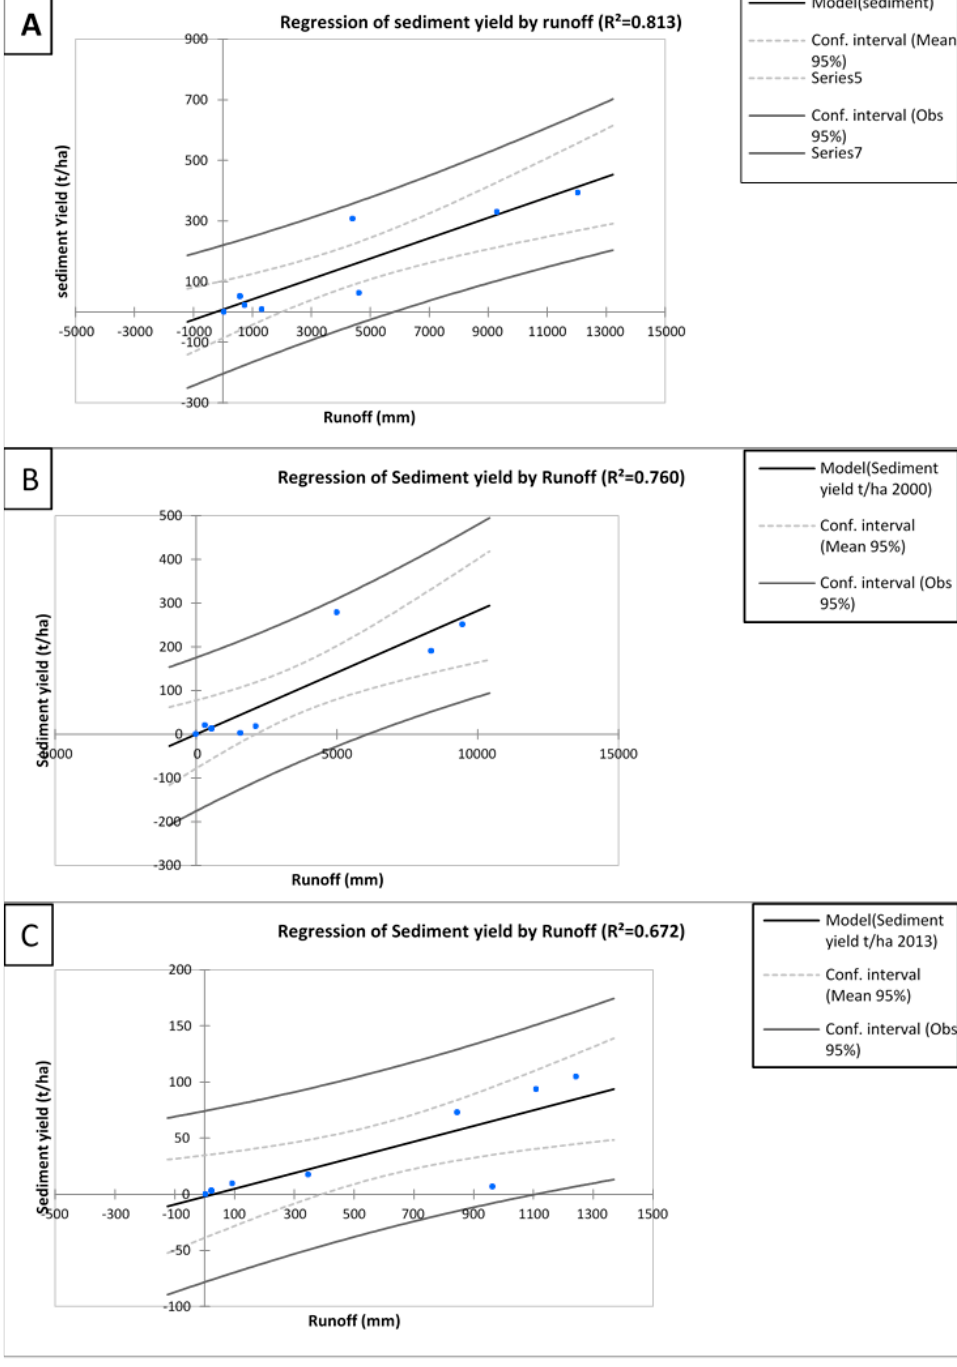
Figure 4. Bivariate relationship between runoff and sediment yield. Note the differences in correlation coefficient (R2) values in the three years. ( A ), ( B ) and ( C ) represent the scenarios in 1975, 2000 and 2013, respectively.